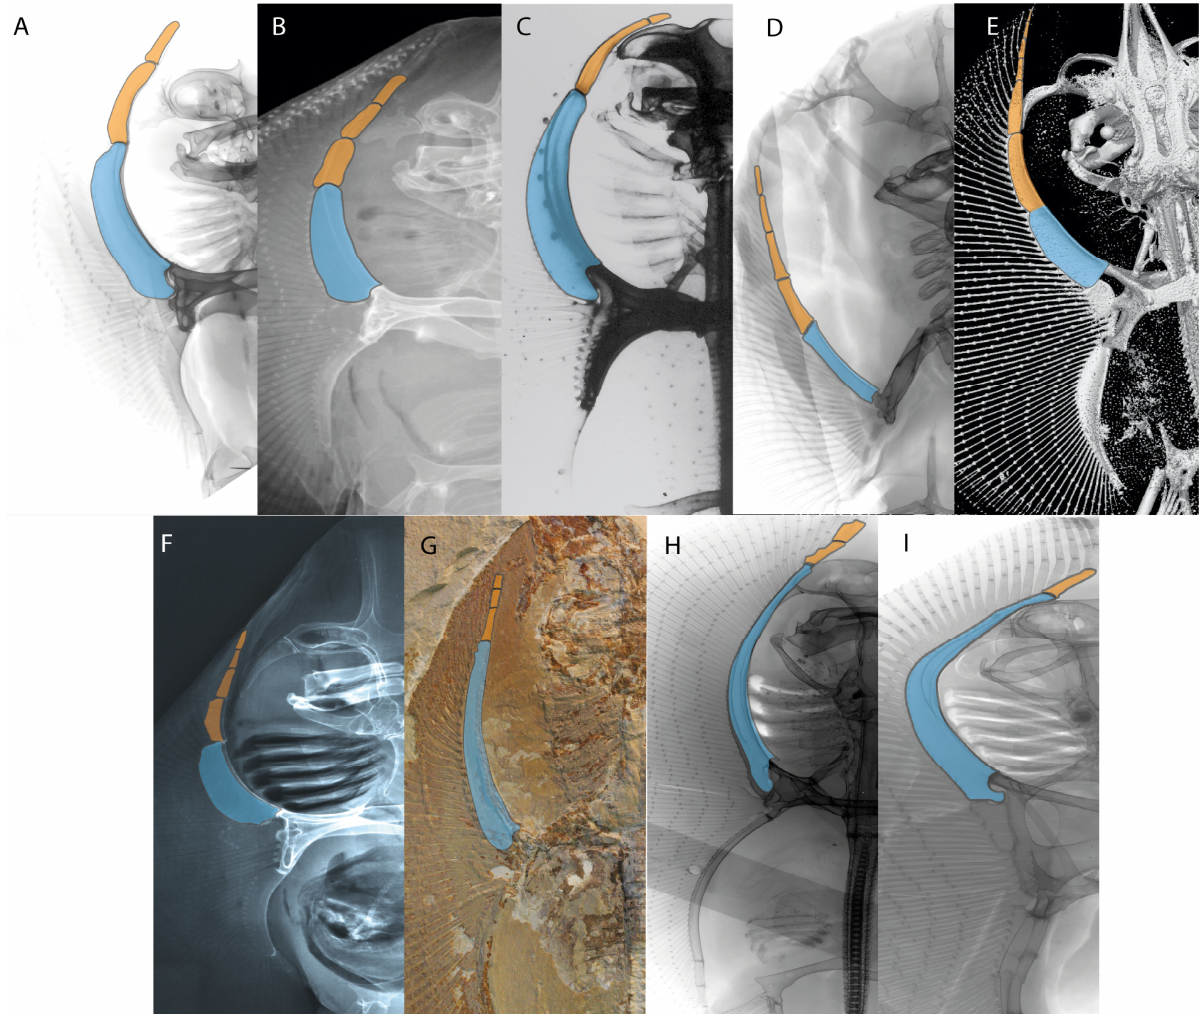
Figure 44. Dorsal and ventral views of the pectoral girdle of selected batomorphs. State (0): ( A ) Platyrhina sinensis (MNHN 1307); ( B ) Platyrhinoidis triseriata (MNHN 3211); ( C ) Zanobatus sp . (MNHN 1989. 12. 91); ( D ) Narcine bancroftii (CAS 18246); ( E ) Raja clavata (BRC–Raja); ( F ) Zapteryx exasperata (CNPE-IBUNAM 17824); ( G ) † “Rhinobatos” maronita (NHMUK-PV-P4012). State (1): ( H ) Urolophus kaianus (NHMUK 1879.5.14.424). State (2): ( I ) Gymnura marmorata (CAS-SU 11587). Prop- terygium colored in blue, segments of propterygium in orange. 109. Interaction between mesopterygium and propterygium: (0) Fused; (1) separated.